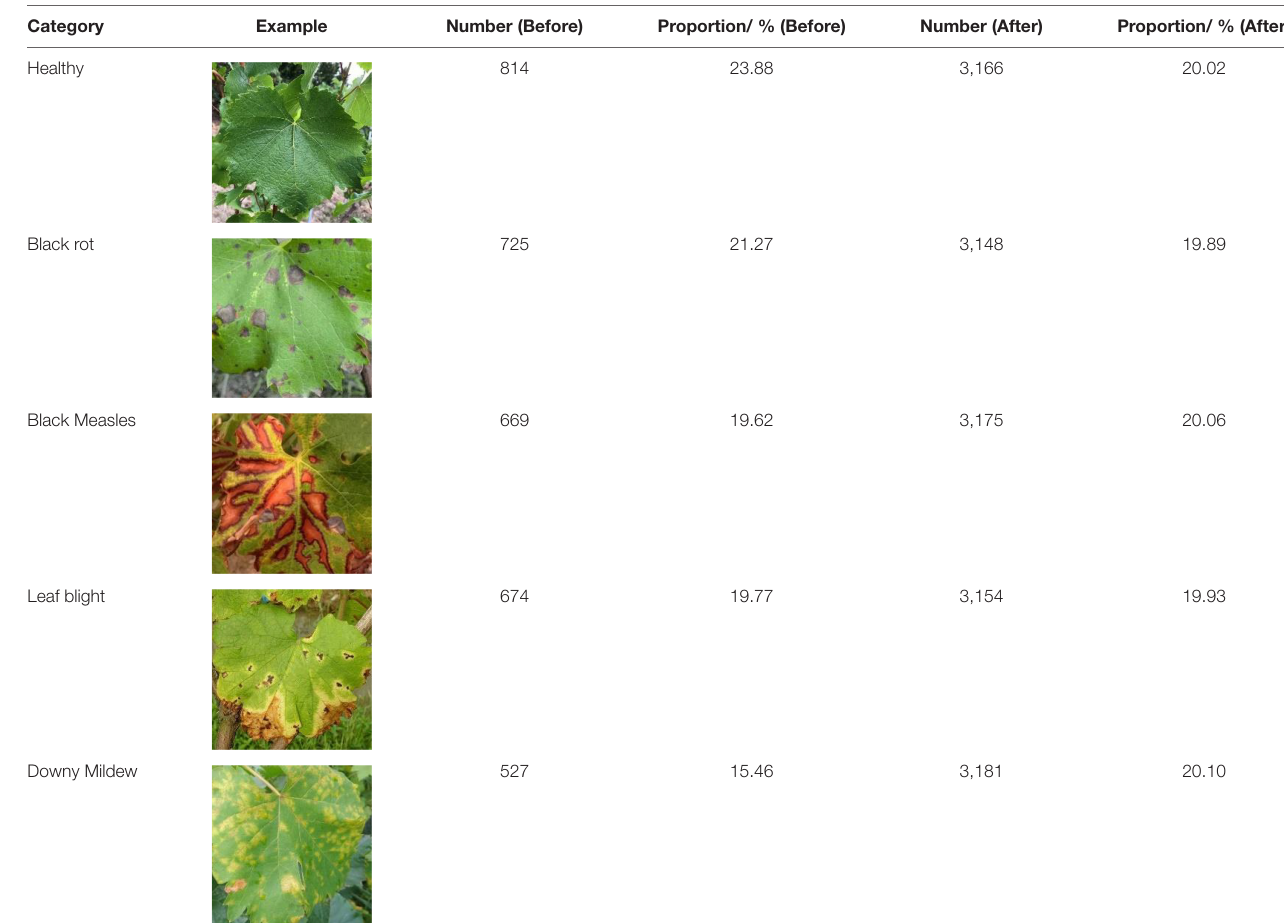
FIGURE 1 | A working principle diagram of the system. TABLE 1 | Number and proportion of grape leaf